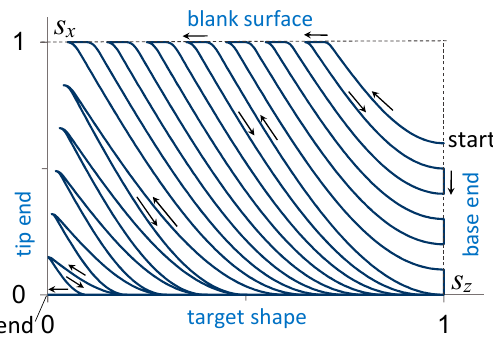
Figure 6. Normalized tool paths used in the experiments. The roller moves along the curved path elements between the base side of the target shape and the tip side of the blank surface. The radial feed to the target shape increases from the base side to the tip side.